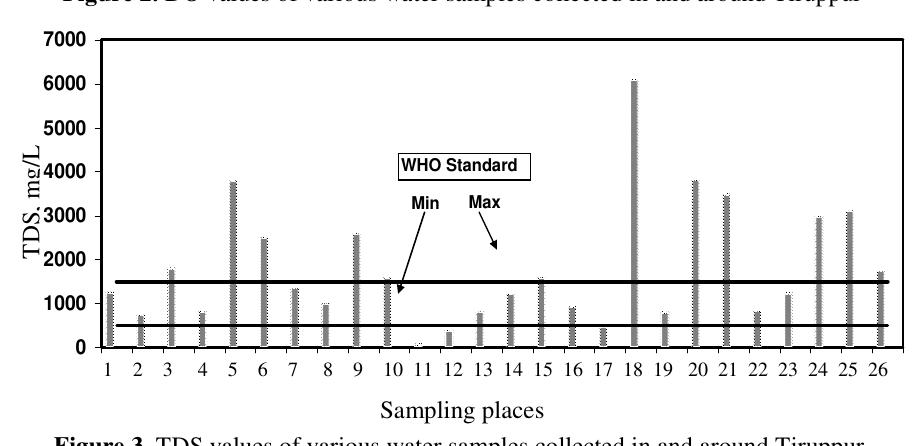
Figure 3. TDS values of various water samples collected in and around